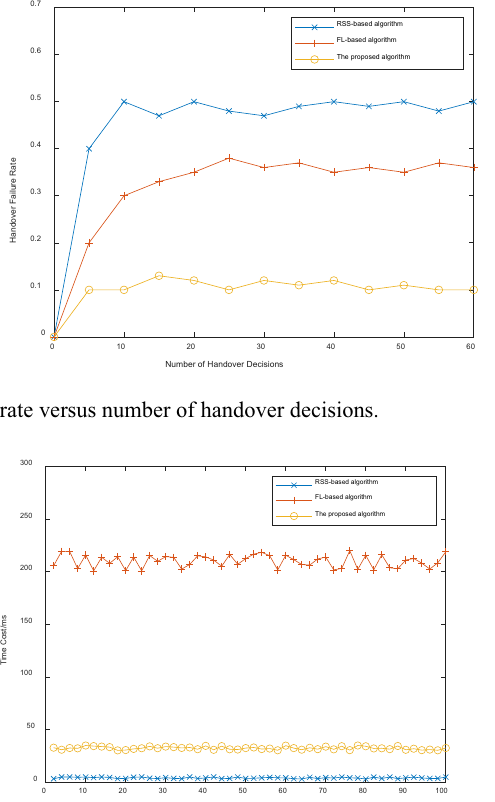
RSS-based algorithm FL-based algorithm The proposed algorithm